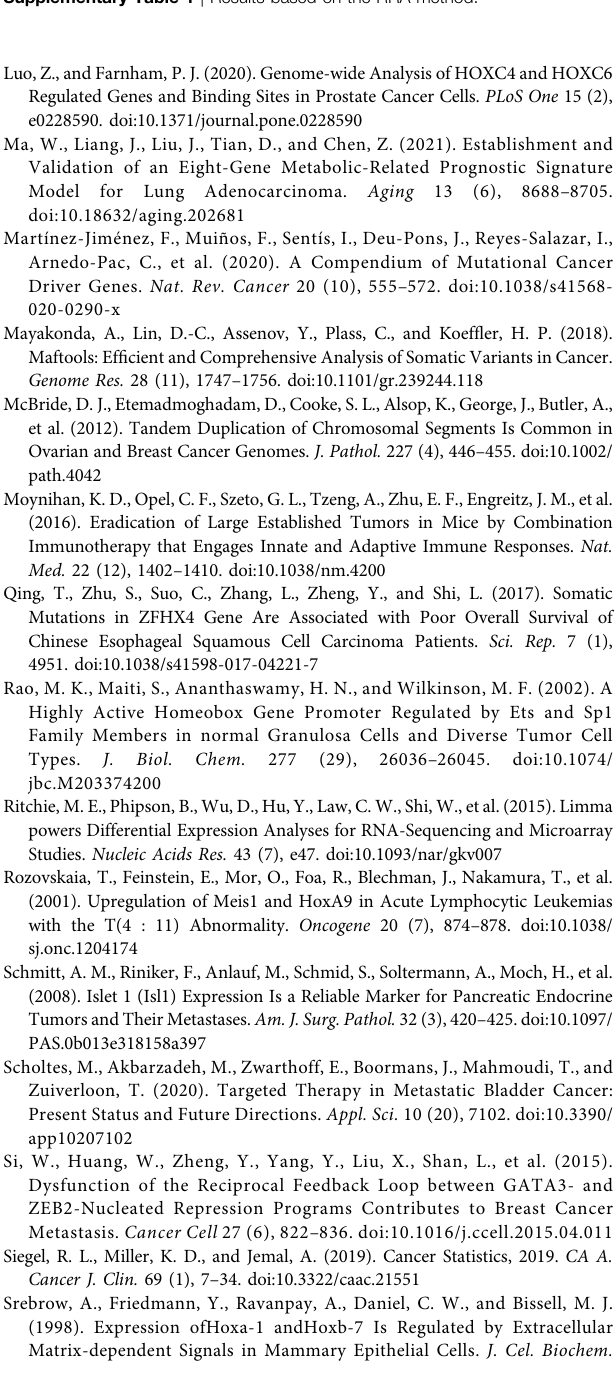
Supplementary Figure 1 | Pancancer analysis of the six homeobox genes. Supplementary Figure 2 | Correlation analysis of the six homeobox genes and BLCA driver genes. Supplementary Figure 3 | Correlation analysis of these six genes and cytokines related to T cell function. Supplementary Figure 4 | Calibration curves of the signature model in predicting one-, three-, and fi ve-year OS in the training set (A – C) , testing set (D – F) , and entire dataset (G – I) . Supplementary Table 1 | Results based on the RRA